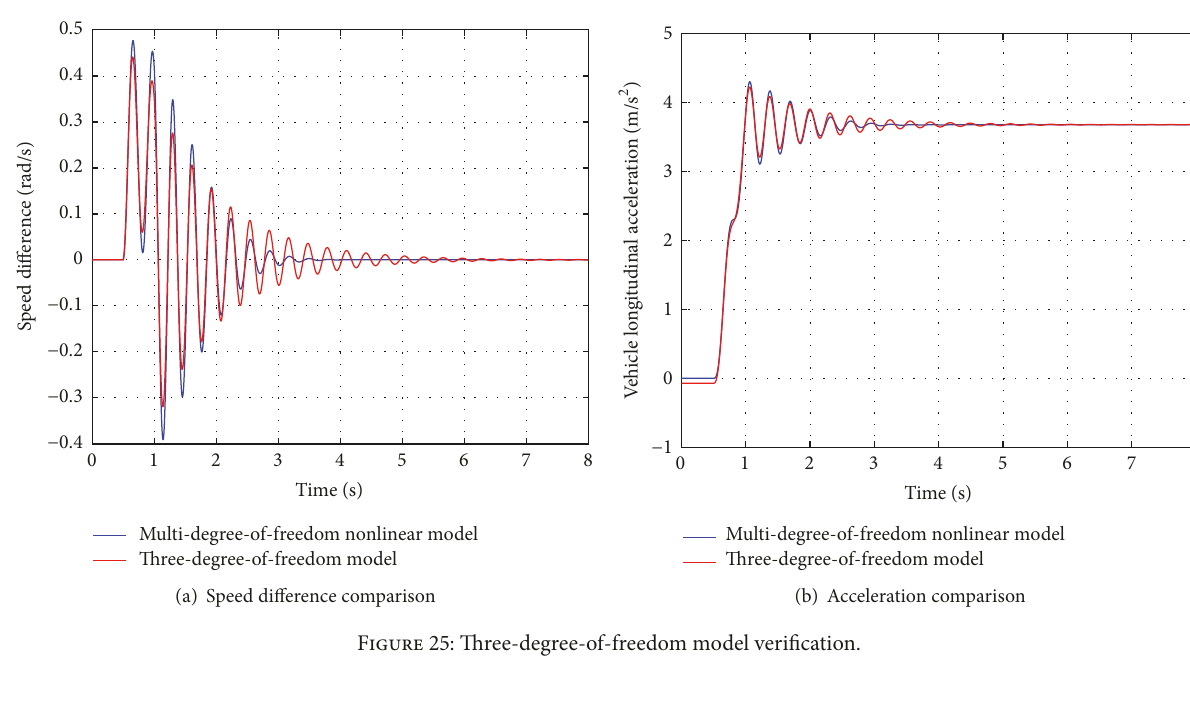
Figure 24: Two-degree-of-freedom model verification.